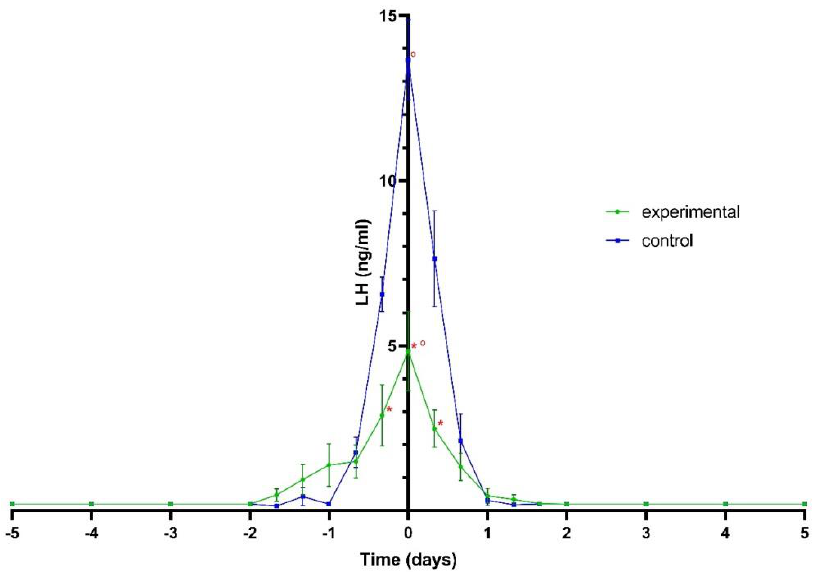
Figure 2. The profiles of LH (ng/mL, mean ± SE) in peripheral plasma in experimental bitches in experimental bitches treated with aglepristone ( n = 7) and in control bitches ( n = 7). Hormone profiles were related to the day of LH peak (Day 0).